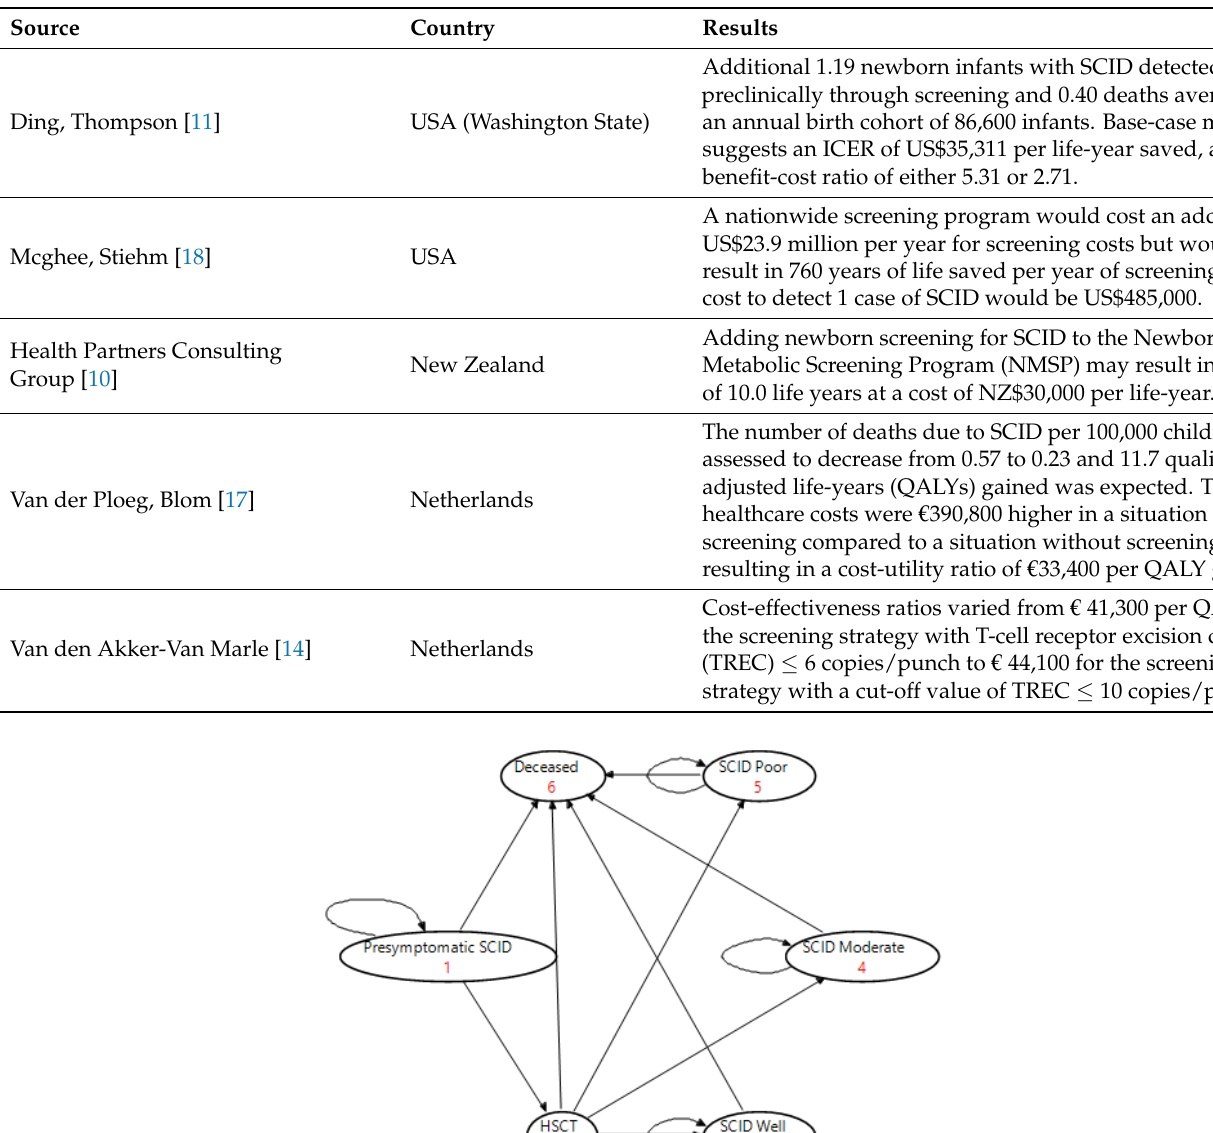
Figure 1. Health state transition diagram for SCID Markov model. Table 1. Published cost-effectiveness analyses of newborn screening (NBS) for severe combined im- munodeficiency (SCID).